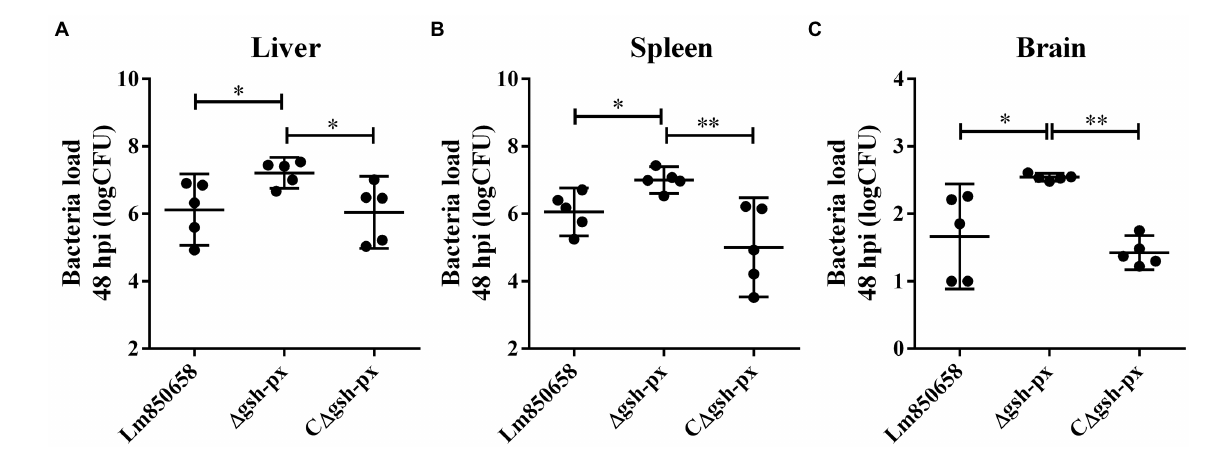
FIGURE 5 Deletion of gsh-px enhanced the virulence of L. monocytogenes to mice. Mice were infected with 10 7 CFU by intraperitoneal injection with Lm850658,